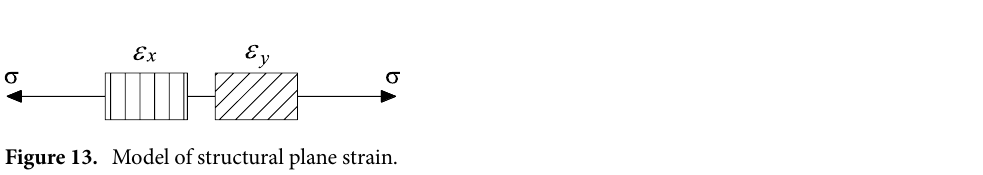
Figure 13. Model of structural plane